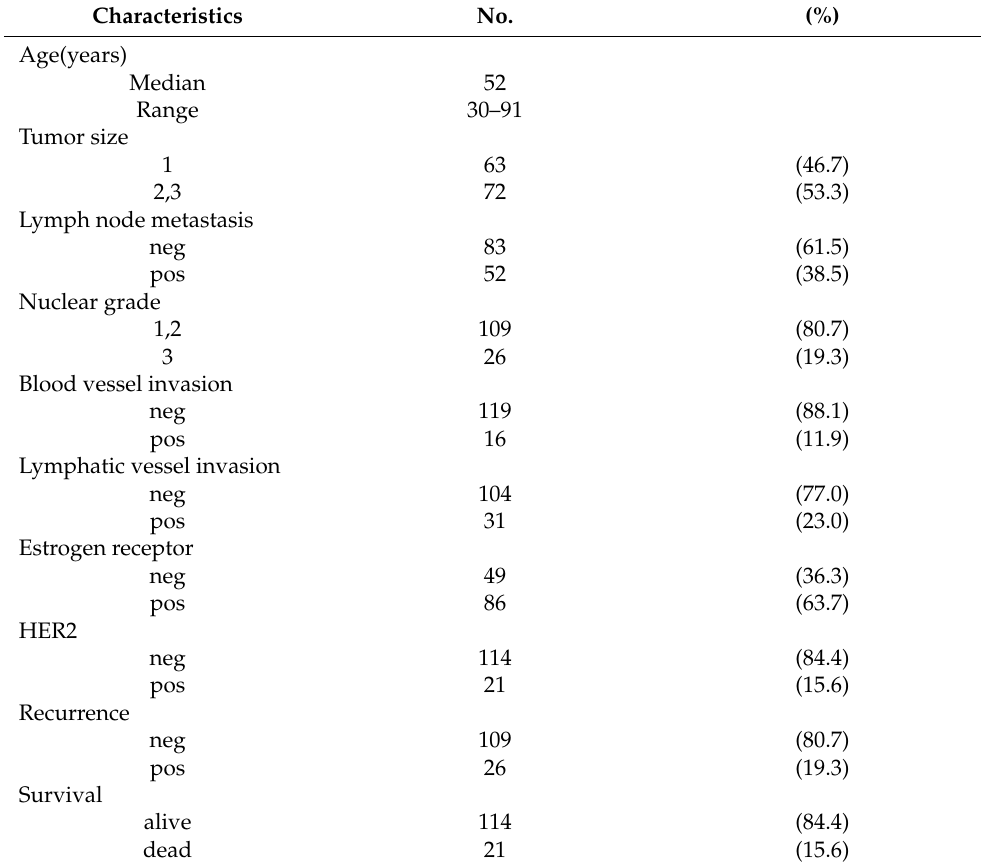
Table 1. Patient